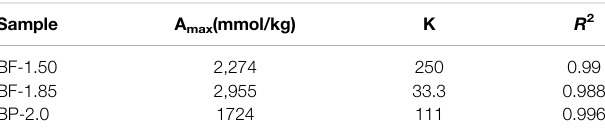
TABLE 2 | Langmuir parameters of Pb 2+ adsorption on BF-1.50, BF-1.85, and BP-2.0.